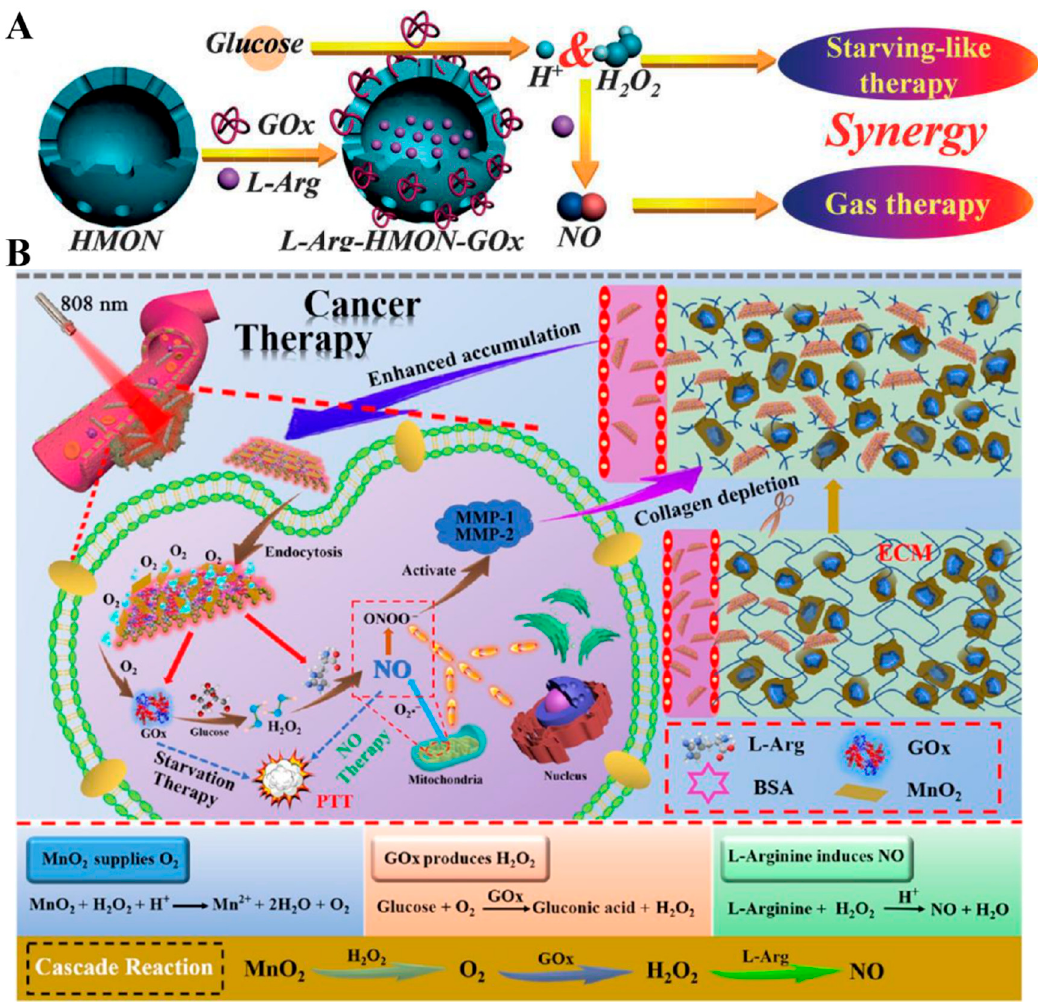
Figure 9. ( A ) Schematic diagram of the construction of L-Arg–HMON–GOx for synergistic cancer therapy. Reproduced with permission from [104], Angewandte Chemie International Edition, 2017; and ( B ) schematic diagram of the preparation of the BPNs–Arg–GOx@MnO 2 (BAGN) nanosystem and the intracellular NO release. Reproduced with permission from [105], ACS Applied Materials & Interfaces, 2021.